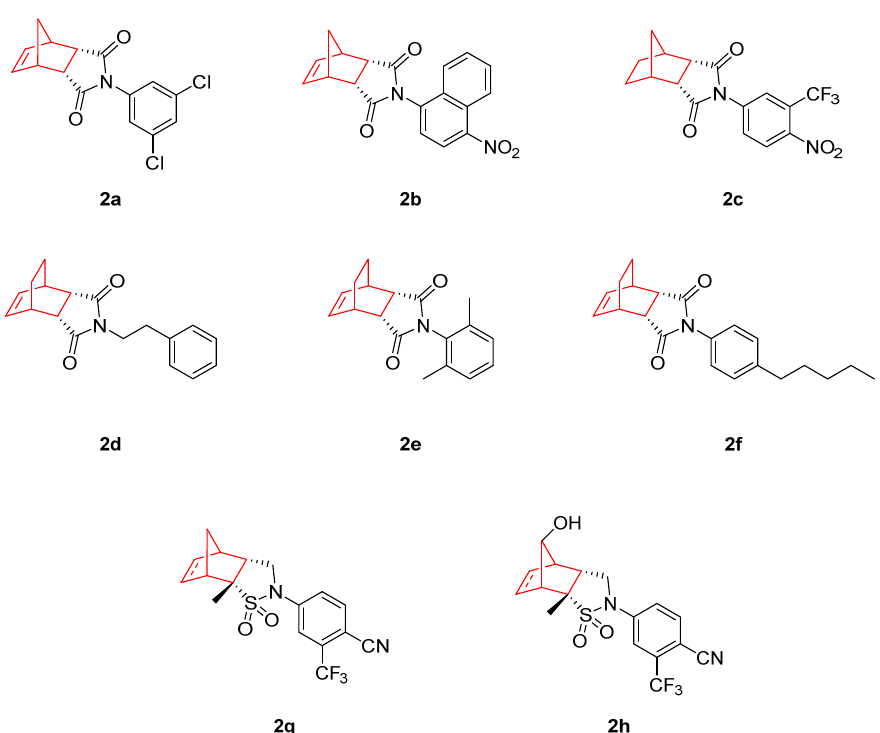
Figure 2. Androgen receptor (AR) antagonist with antitumor activity based on bicyclic imides containing the norbornene structure (compounds 2a–2f ) [29–31] and bicyclic sultams (compounds 2g–h ) [32].